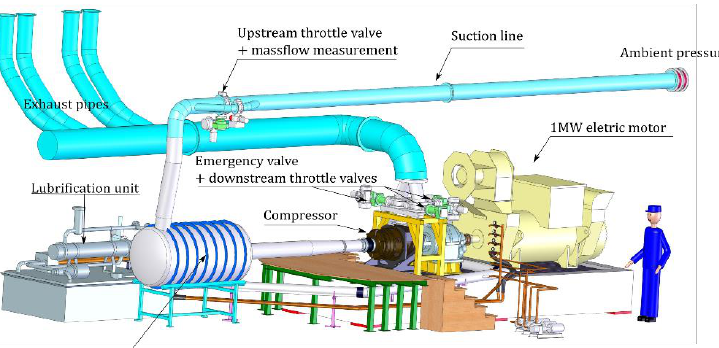
Figure 1. Meridional view of the compressor stage .